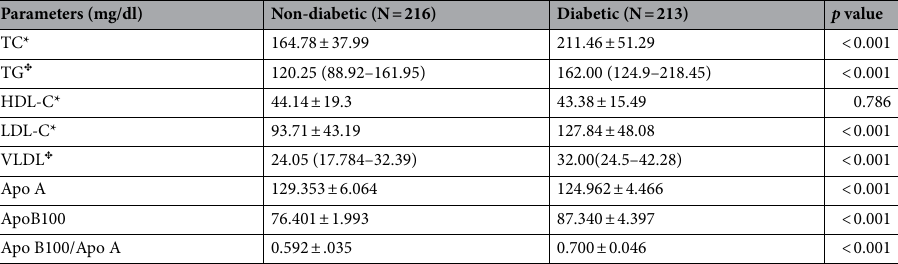
Table 1. Comparison of the mean lipid profile and apolipoprotein levels in diabetic and non- diabetic individuals. ✥ P value ≤ 0.05 was considered statistically significant. *Student t-test, Data are shown as mean ± SD. ✣ Mann–Whitney U test. Data are shown as median (interquartile range).